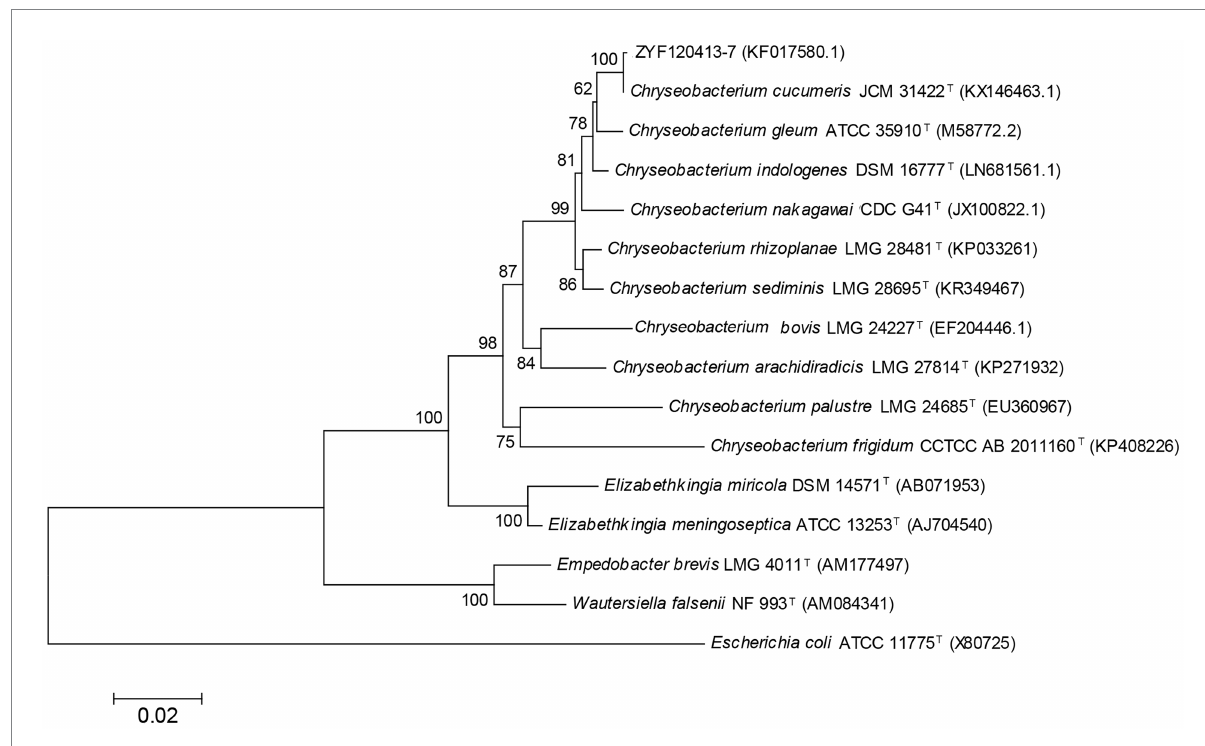
FIGURE 2 Phylogenetic tree based on 16S rRNA sequences of stain Chryseobacterium cucumeris ZYF120413-7. Phylogenetic relationships were inferred using the Neighbor-Joining method with 1,000 bootstrap replicates. Bootstrap values above 50% are shown next to the